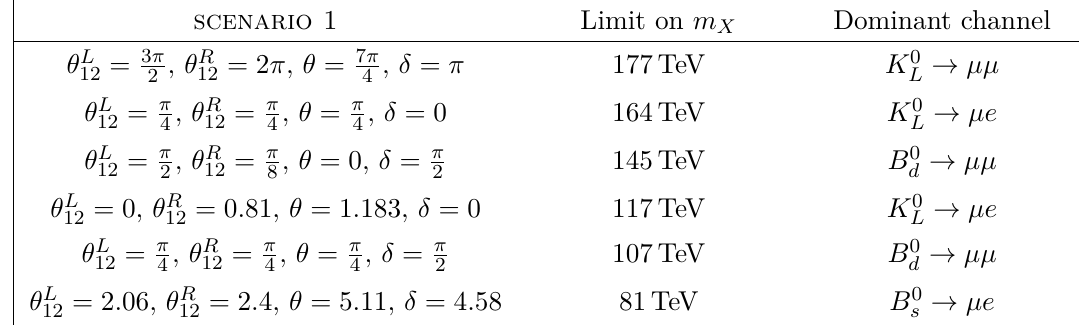
Table 4 . Limits obtained for the gauge leptoquark mass X µ for different choices of the mixing angles appearing in eq. (3.3) ordered from largest to smallest. The decay process from which the dominant limit arises is also listed. In some cases, even though it is helicity-supressed, the dominant limit will still arise from K 0 decays. The angles in the fourth row were first used in [29] from which L they obtained a limit of 86 TeV from B 0 → µµ when the muon and electron mass were neglected. d/s We find similar limits however we highlight the importance of including the muon mass as the channel K 0 → µe still forms the dominant limit for this scenario. A numerical scan finds the limits L in this scenario can vary from 81 – 177 TeV.